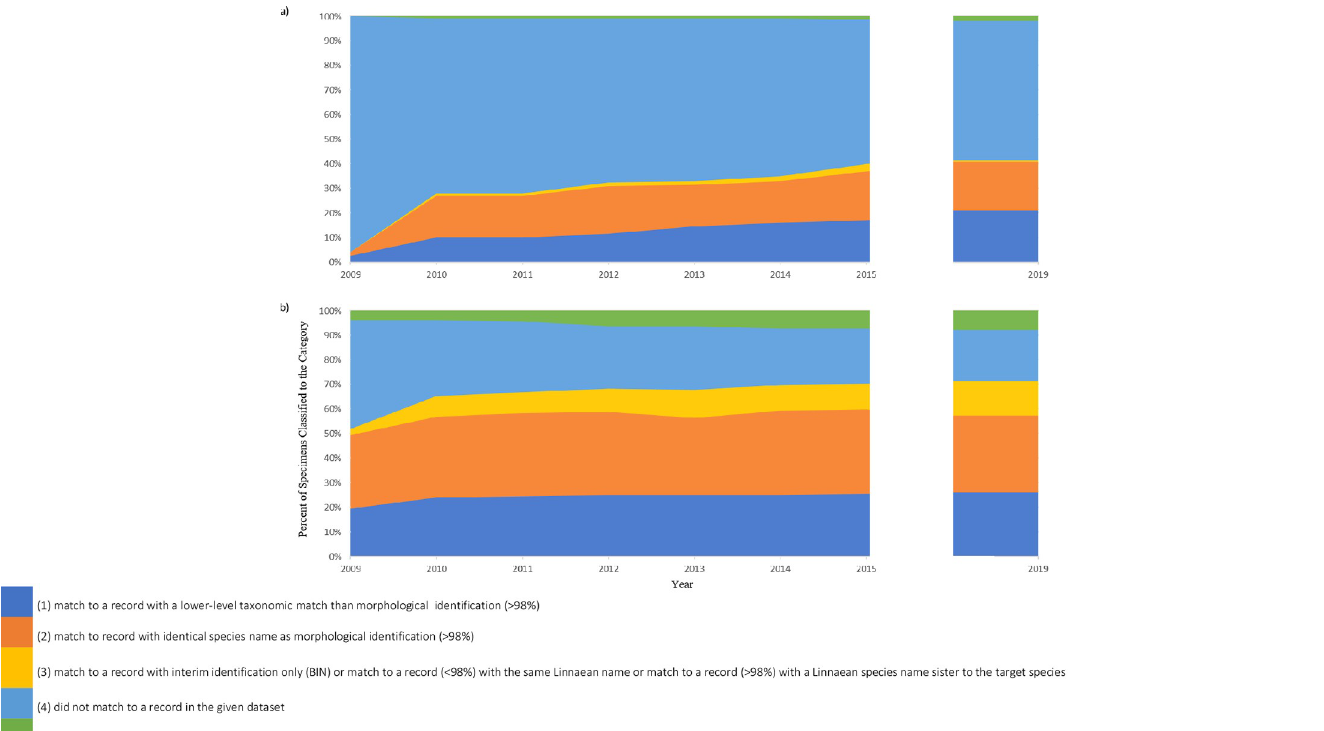
Fig 2. Development of concordance between the PRDB and SLBR with morphological identification over the course of 10 years, analysis of PRDB = Fig 2a, analysis of SLBR = Fig 2b.